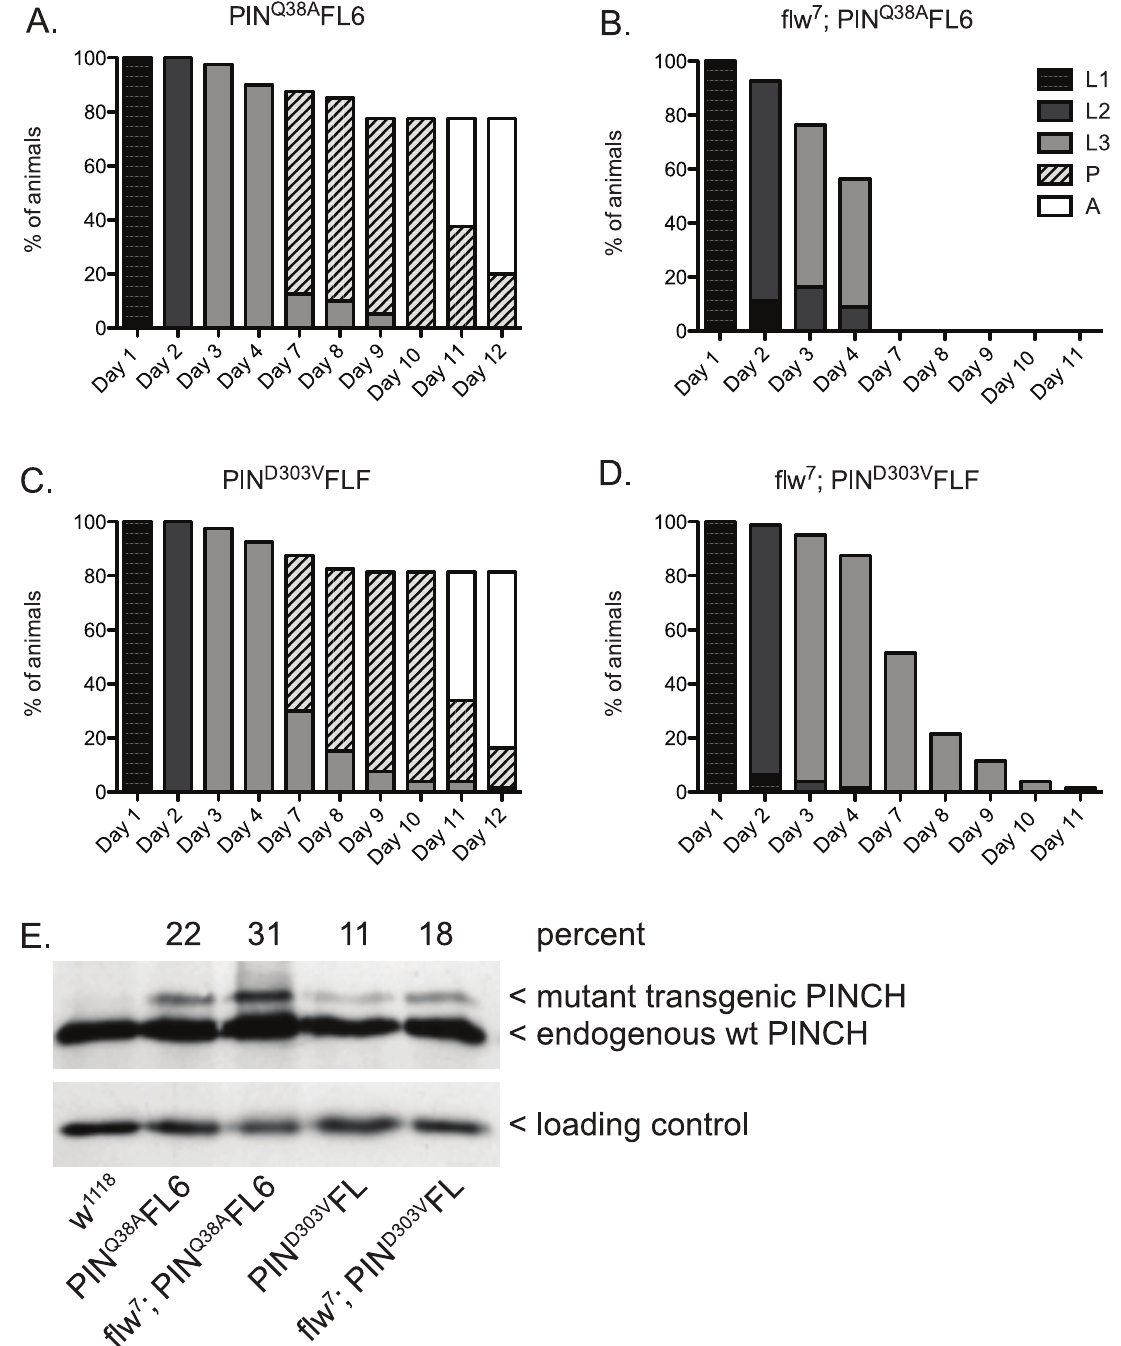
Figure 4. PINCH associates with ILK and RSU1 in order to suppress the larval lethality of flw 7 mutants. Survival curves show normal developmental progression upon expression of transgenic PINCH Q38A Flag (A) or PINCH D303V Flag (C) alone. Pupae present at day 12 subsequently progress to adulthood. Upon introduction of the mutant PINCH transgenes into a flw 7 background (B,D), arrest during the larval stages is observed. E) Western blot plus densitometric analysis for PINCH shows the relative level of expression of the mutant Q38A and D303V transgenes as a percentage of endogenous PINCH. The ribosomal protein RACK1 was used as a loading control. four-day time point we used to analyze muscle integrity (Figure scored for detachment, we have used this group of muscles as a S4). flw mutants are reported to exhibit larval muscle detachment read-out for muscle integrity. Zasp-GFP controls show very little detachment of the VIS muscles (Figure 6A, 6F). Additionally, expression of a single copy of the PINCH-Flag, PINCH Q38A Flag or PINCH D303V Flag transgenes in the Zasp-GFP background does